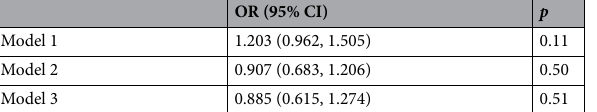
Table 4. The association between serum folate levels and hypertension. Model 1: not adjusted; model 2: adjusted for age and sex; model 3: adjusted for age, sex, education level, household income, occupation, marital status, cigarette smoking, high-risk drinking, strength exercise, obesity, diabetes mellitus, family history of hypertension, energy intake, and sodium